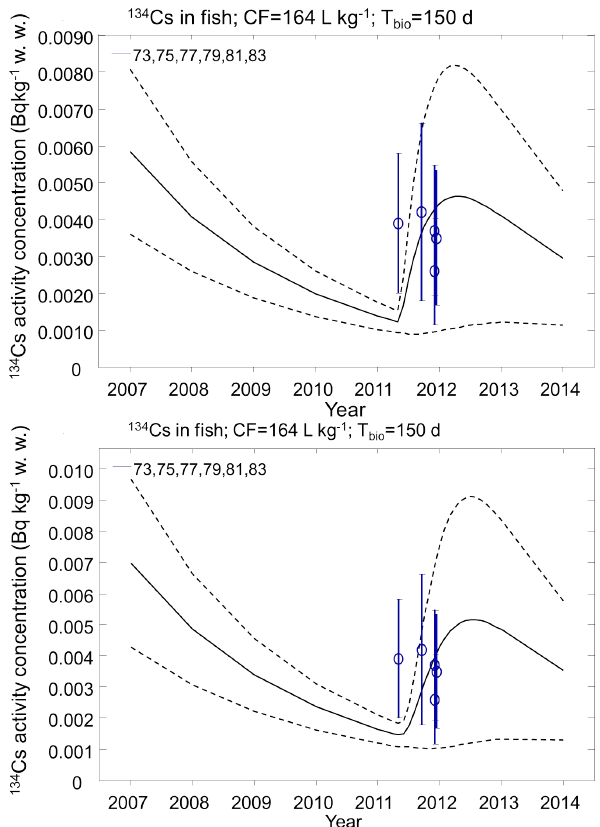
Fig. 3. Curves of 134 Cs activity per unit mass in fish using two mod- els and measured values of 134 Cs in BS fish. Upper panel: single- compartment model curves ignoring growth G and Cs uptake from water k w . Lower panel: two-compartment model used with G and k w values given in the text, otherwise the same as in Fig.